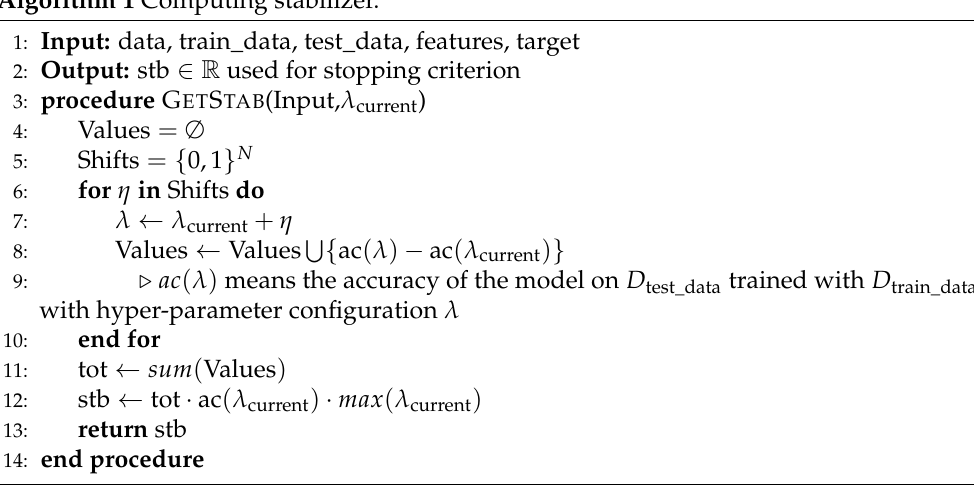
Algorithm 1 Computing stabilizer.